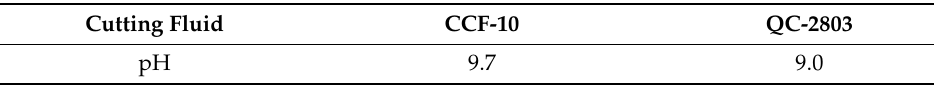
Figure 3. Surface tension for two cutting fluids. Table 4. pH values for two cutting fluids.